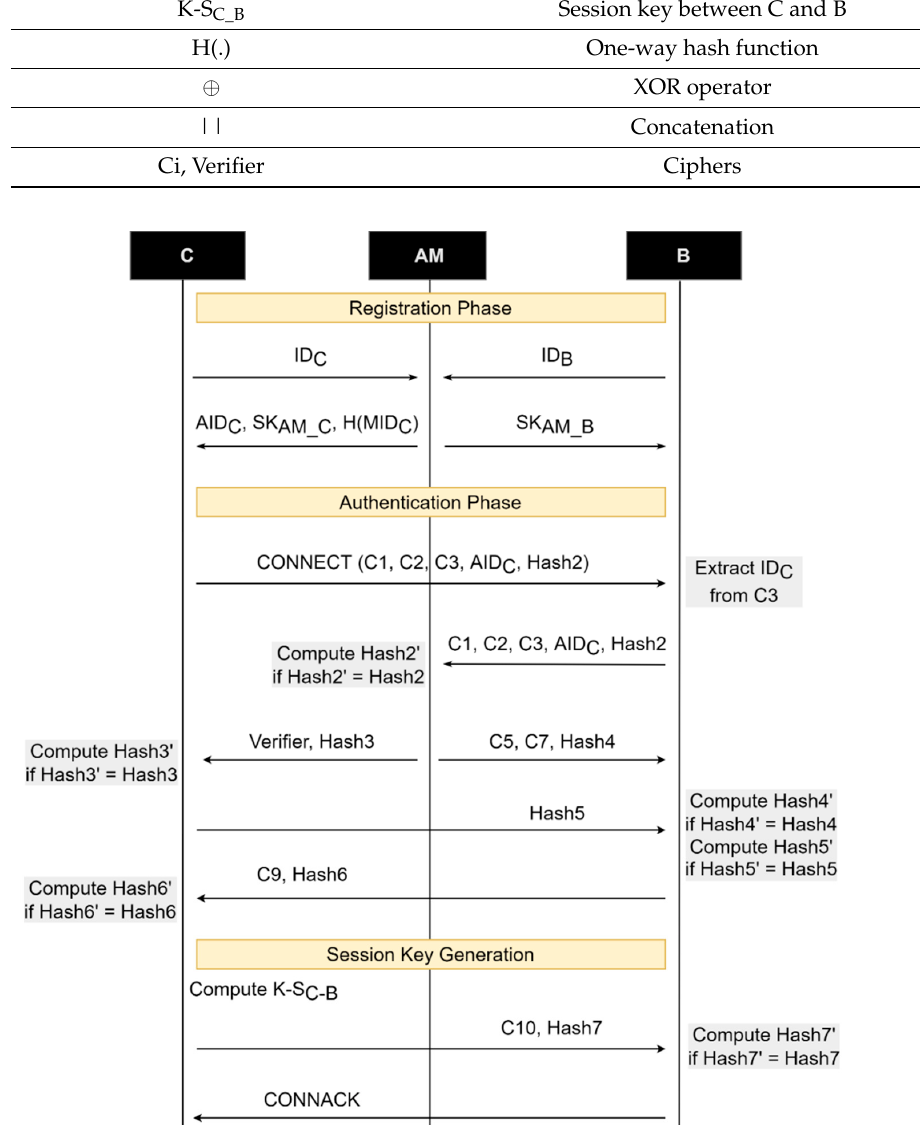
Figure 8. Authentication scheme’s steps. Table 3. Notation used in the authentication scheme.